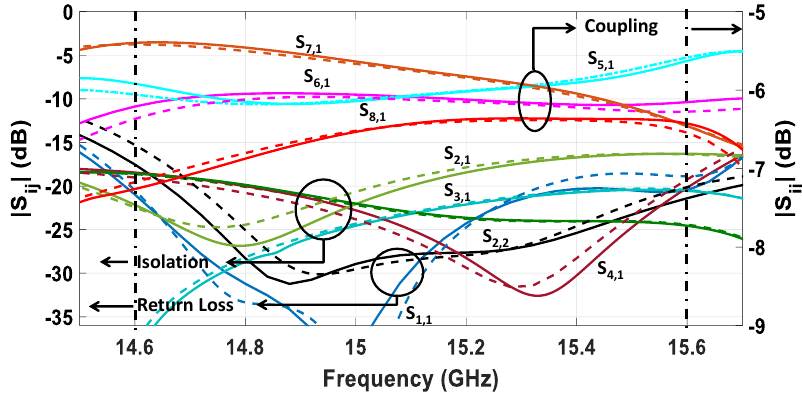
Figure 3. Simulated results of return losses, couplings, and isolations by Mode-Matching (MM) (solid lines) and CST (dashed lines) considered in (1) for Port 1 and Port